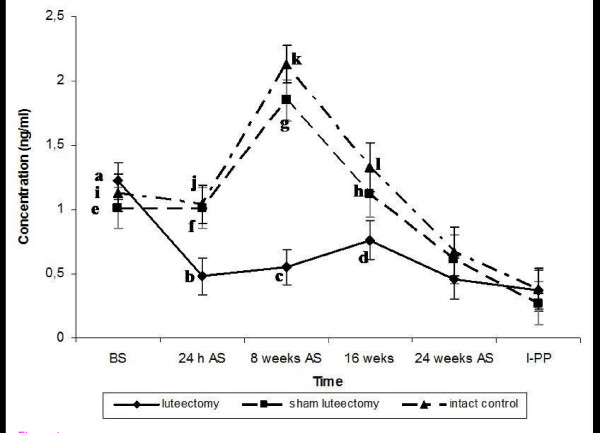
Effect of luteectomy on the progesterone plasma concentration in viviparous lizard Barisia imbricate. Patterns of progesterone plasma concentrations in luteectomised, sham luteectomised and intact pregnant females of the viviparous lizard Barisia imbricata imbricata. BS: before surgery, W-AS: weeks after surgery, I-PP: immediately post-parturition a is significantly higher with respect to remaining times of gestation of luteectomised lizards group at p < 0.01; g is significantly higher with respect to remaining times of gestation of sham luteectomised lizards group at p < 0.01; k is significantly higher with respect to remaining times of gestation of intact lizard group at p < 0.01; b is significantly less with respect to f and j at p < 0.01; c is significantly less with respect to g and k at p < 0.01; d is significantly less with respect to l at p < 0.01.